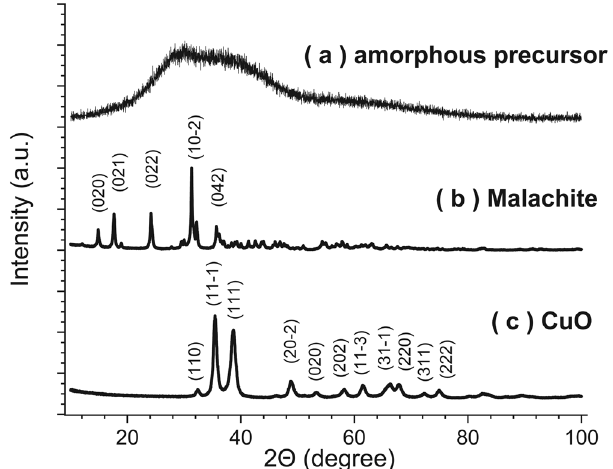
Figure 2. Recorded XRD diffractograms of ( a ) the freshly washed precipitate (i.e. the precursor phase) from a stoichiometric mixture, ( b ) the precursor phase after long drying at room temperature in air, which matches the reference pattern of malachite 32 and ( c ) the final CuO product phase after calcination, which matches the reference pattern of CuO 33